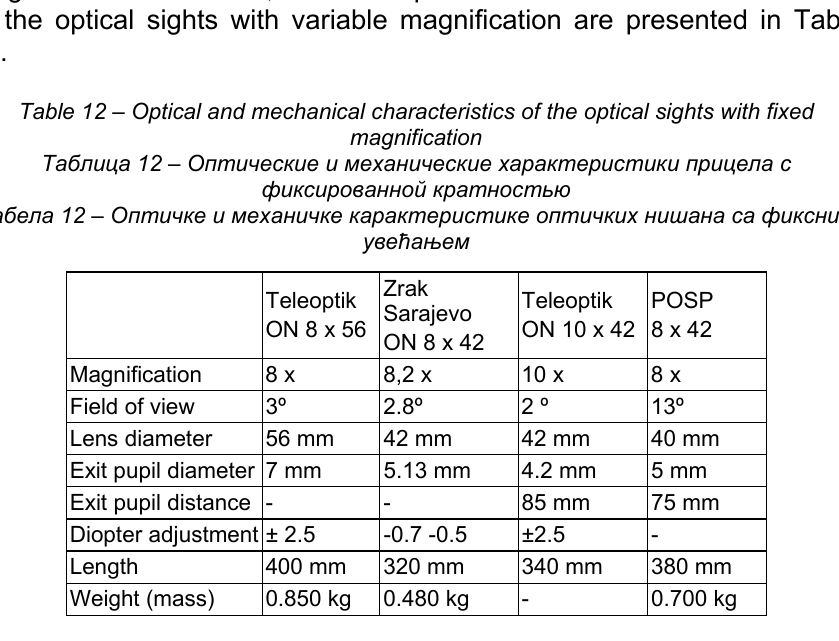
Table 13 – Optical and mechanical characteristics of the optical sights with variable